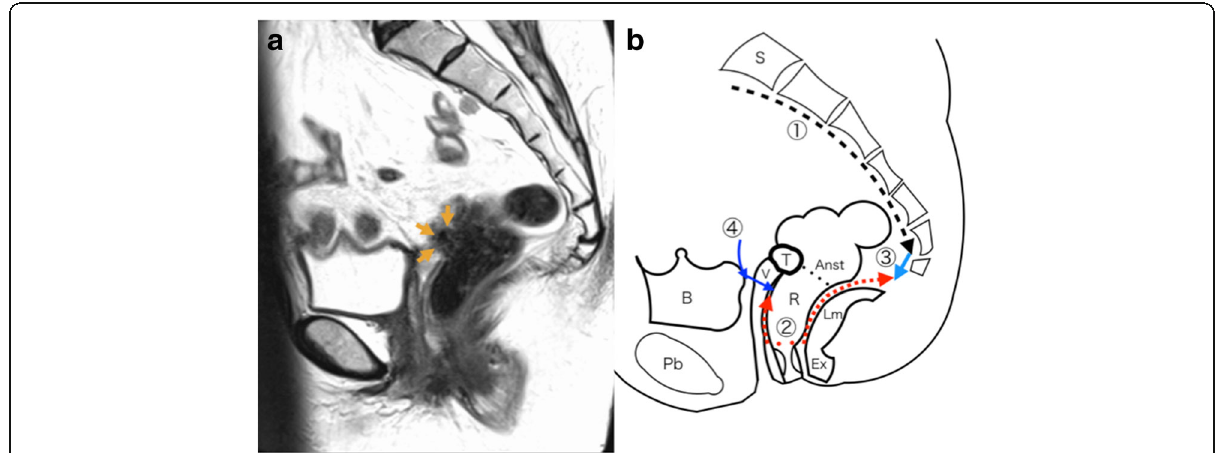
Fig. 1 a Magnetic resonance imaging (MRI) T2-weighted images. Orange arrows indicate the recurrent tumor in the vaginal stump. b Schema of the MRI. Arrow 1, dissection along the anterior sacrum; dotted red arrow 2, dissection by transanal minimally invasive surgery (TEA); light blue arrow 3, subsequent dissection to create a communication between the abdominal dissection and the dissection created by TEA; dark blue arrow 4, vaginal transection in the final phase of surgery. T tumor, S sacrum, B bladder, Pb pubis, V vagina, R rectum, Ex external sphincter muscle, Lm levator muscle, Anst anastomosis from the prior